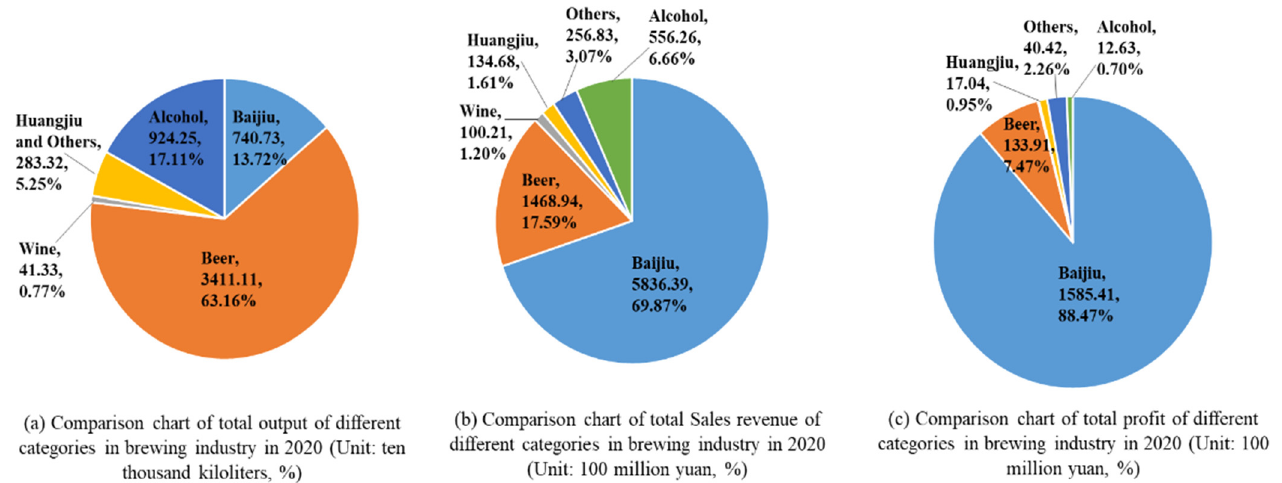
Figure 1. Comparison chart of total output ( a ), total sales revenue ( b ) and total profit ( c ) of different categories in brewing industry in 2020.